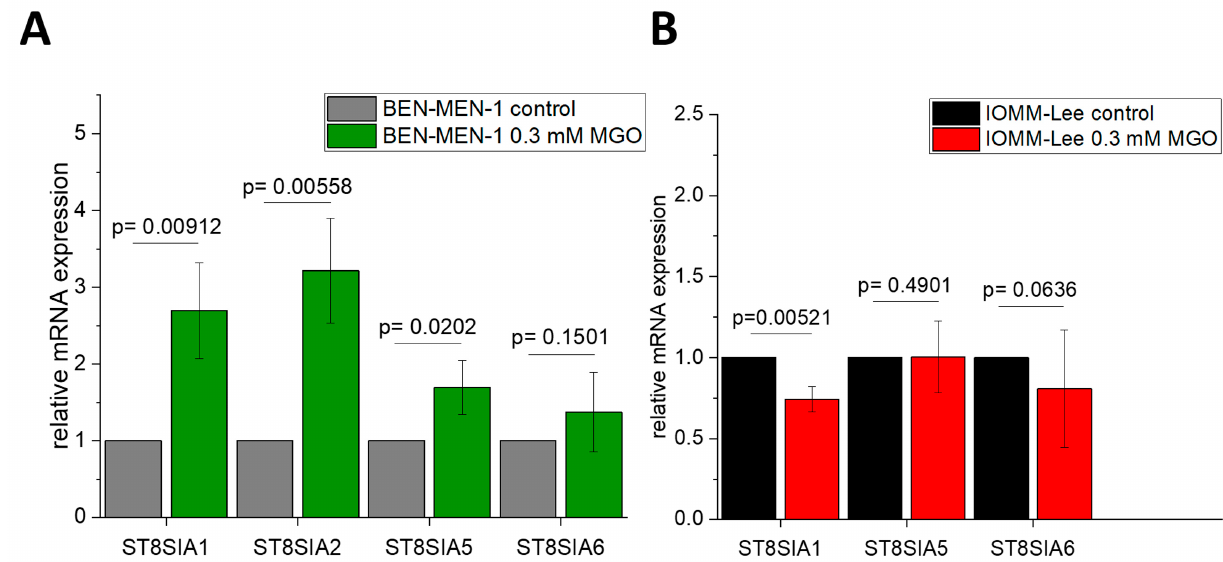
Figure 5. Relative mRNA expression of ST6GALNAC1–6 in BEN-MEN-1 ( A ) and IOMM- Lee ( B ). ( A ): Normalized control (grey) and mRNA expression after 24 h treatment with 0.3 mM MGO (green). ( B ): Normalized control (black) and mRNA expression after 24 h treatment with 0.3 mM MGO ( red ). Statistical analysis was performed using t -test and error bars represent SD (n = 4; ST6GALNAC2 : p = 0.0275 ( A ); ST6GALNAC4 : p = 0.0583 ( A ), p = 0.4882 ( B ); ST6GALNAC5 : p = 0.0366 ( A ), p = 0.024 ( B ); ST6GALNAC6 : p = 0.0339 ( A ), p = 0.1311 ( B )).